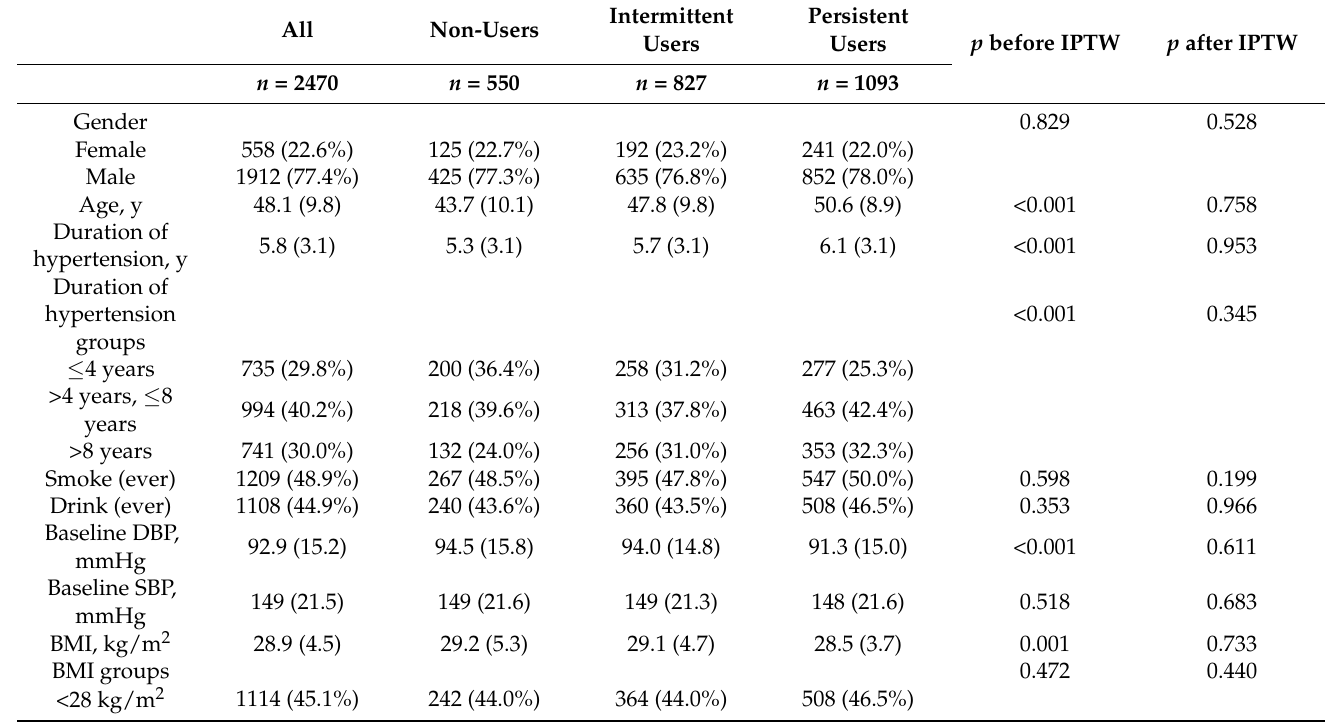
Table 1. Participants’ baseline